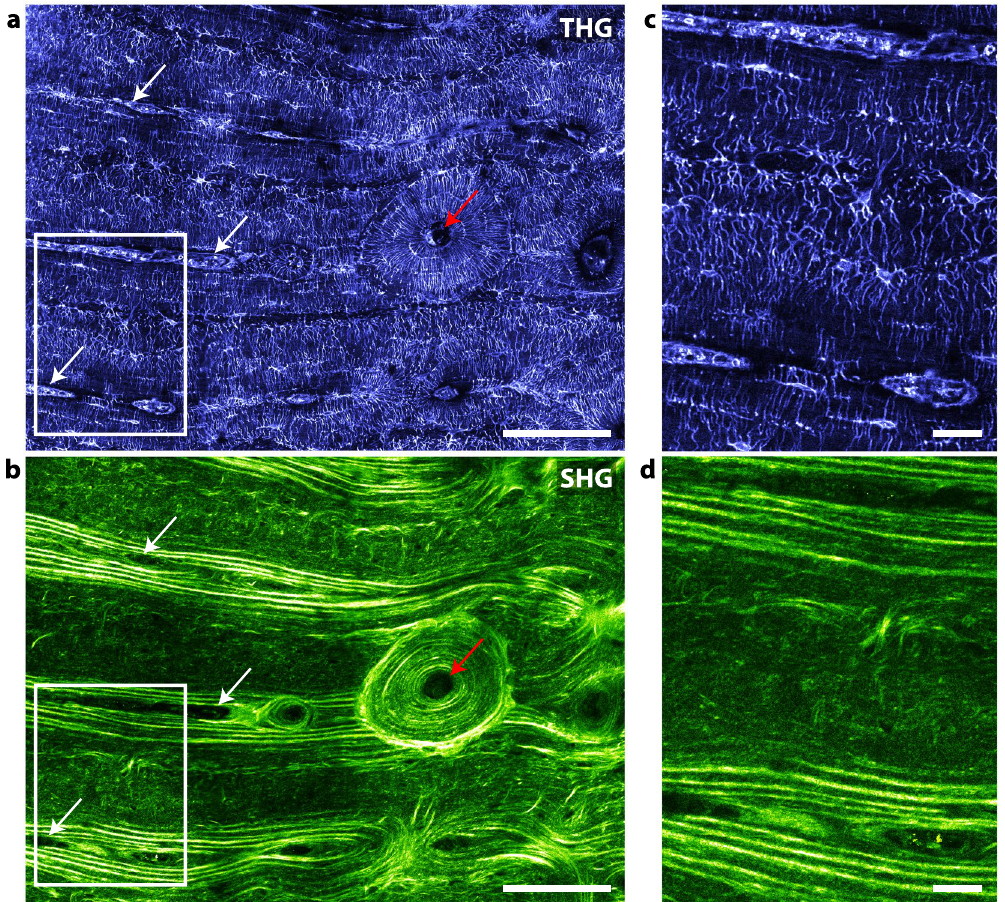
Figure 6. Imaging structural variability in bovine bone. Large-scale image of a transverse section of cortical bovine femur in THG ( a ) and SHG ( b ). This large-scale image includes an osteon with a well-defined radial organization (around the Haversian channel, red arrow), and a surrounding fibrolamellar region. Scale bar, 100 µ m. ( c ) (resp. ( d )), zoom into the rectangle area in ( a ) (resp. ( b )). At the bottom and top parts of the images, lamellar regions surrounding vascular channels (white arrows in ( a , b )) correspond to well-aligned lacunae and canaliculi, while the fibrous region in the center shows rounder lacunae and more disordered canaliculi. Scale bar, 10 µ